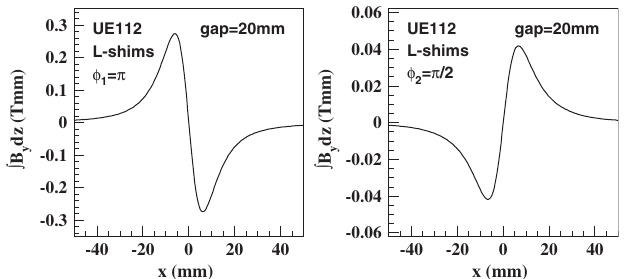
FIG. 7. Gap and shift dependence of the functions R (left) and S (right). R is normalized to one at shift ¼ 0 : 5 (cid:3) 0 . S is normal- ized to one at shift ¼ 0 : 25 (cid:3) 0 . The data are given for the elliptical mode.